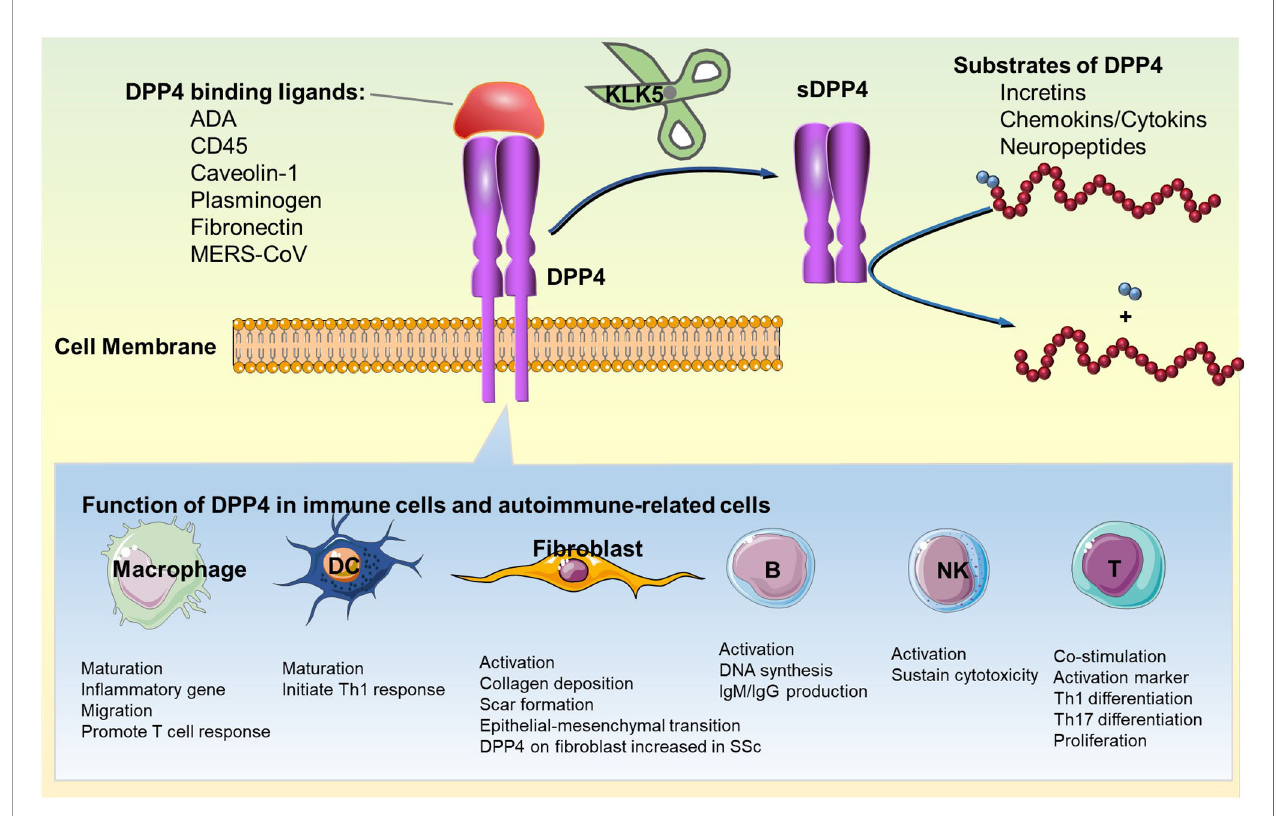
FIGURE 1 | Immunoregulatory function of DPP4: enzymatic and non-enzymatic functions of DPP4 in immune cells and fi broblast are shown. DC, dendritic cell; DPP4, dipeptidyl peptidase-4; IgG, immunoglobulin G; IgM, immunoglobulin M; KLK5, kallikrein-related peptidase 5; sDPP4, soluble DPP4; Th1, type 1 helper T cell; Th17, type 17 helper T